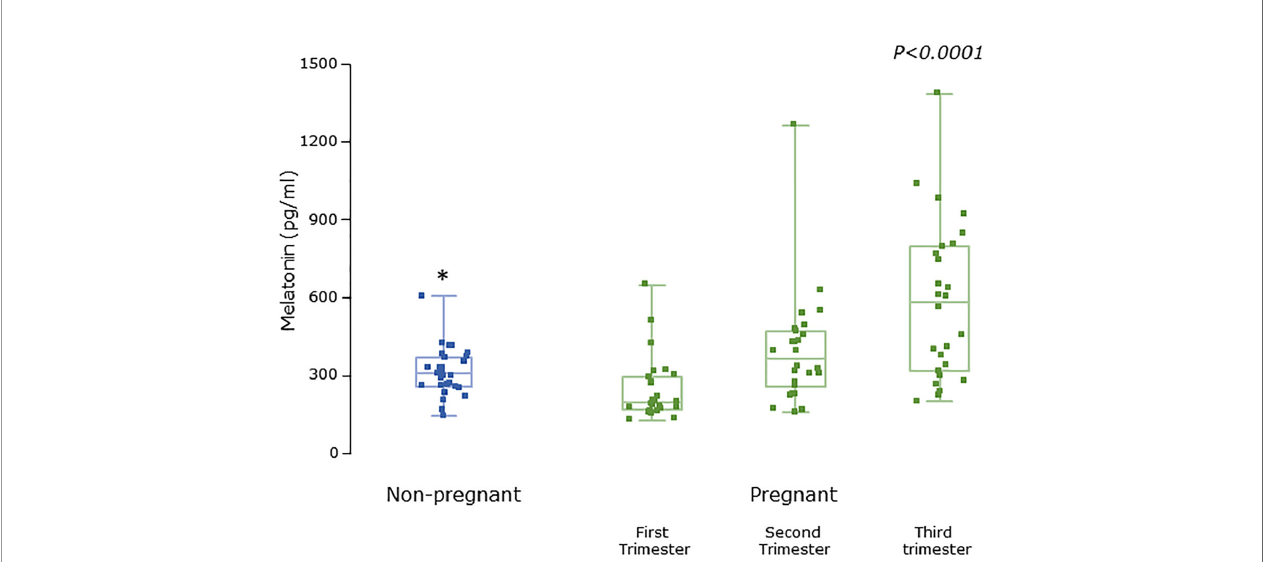
FIGURE 3 | Serum melatonin levels from MEL-P in non-pregnant healthy control subjects (n = 30) compared to pregnant subjects throughout pregnancy (n = 26), *, signi fi cantly different from pregnant women in the fi rst (P = 0.0025), second (P = 0.04), and third (P=0.0005) trimesters, Wilcoxon-Mann Whitney test. P value shown is Friedman test over the trimesters showing increasing melatonin levels (P < 0.0001). Data are shown as median, interquartile, and full range with individual raw data points